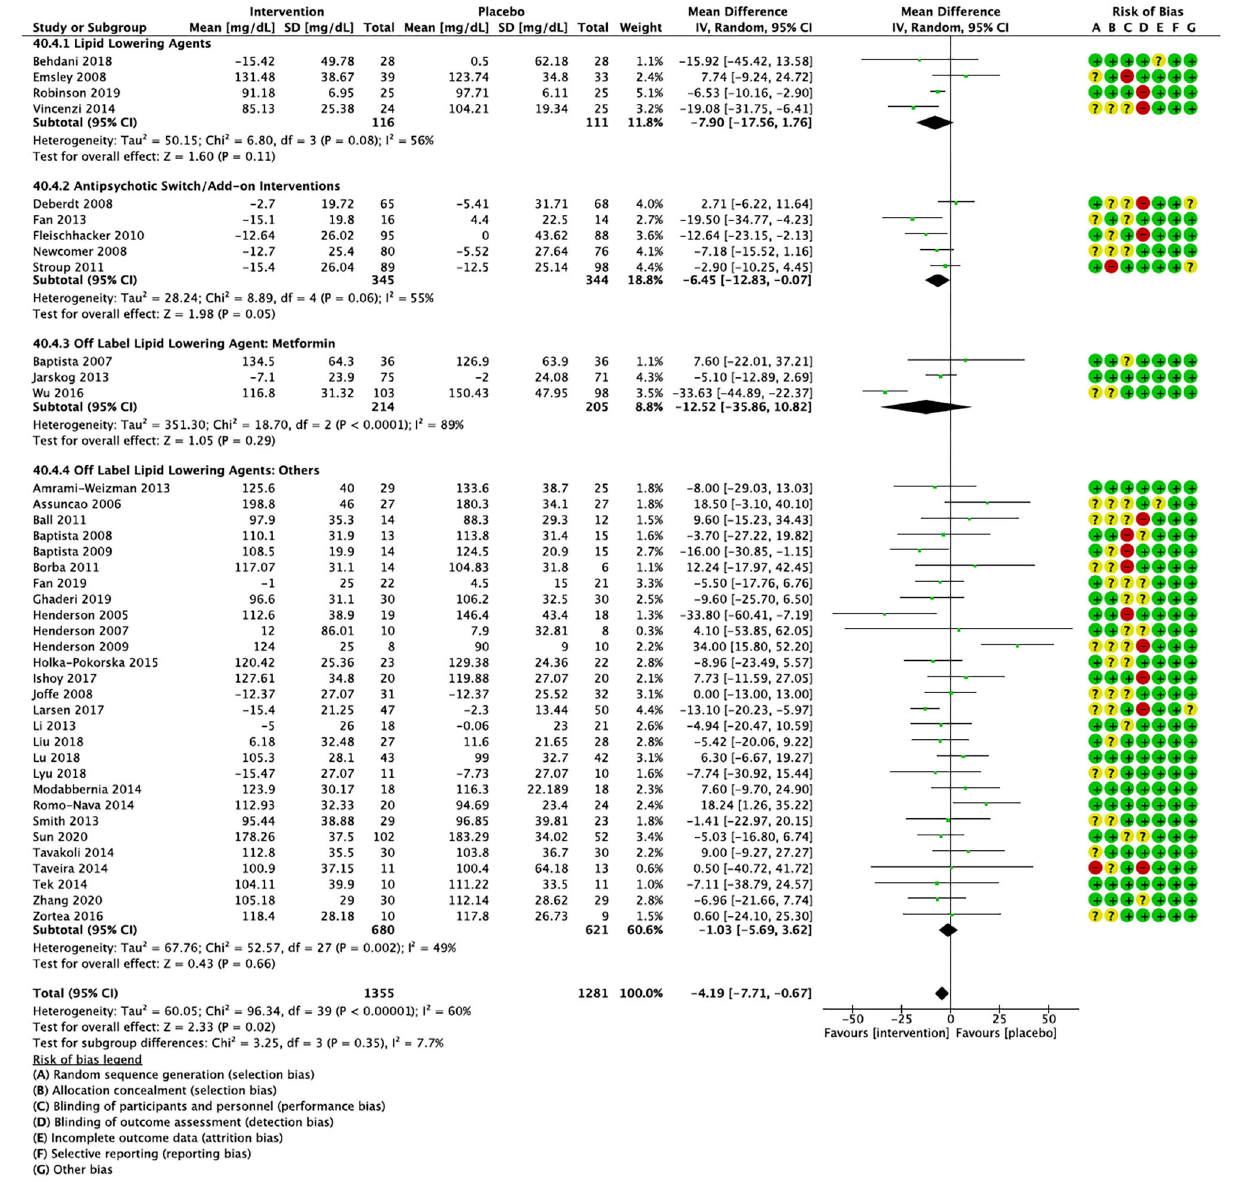
( Supplementary Figure 1 ; N = 38, n = 2,380; WMD = − 1.13 kg, CI: − 2.18, − 0.08; p = 0.03), BMI ( Supplementary Figure 2 ;